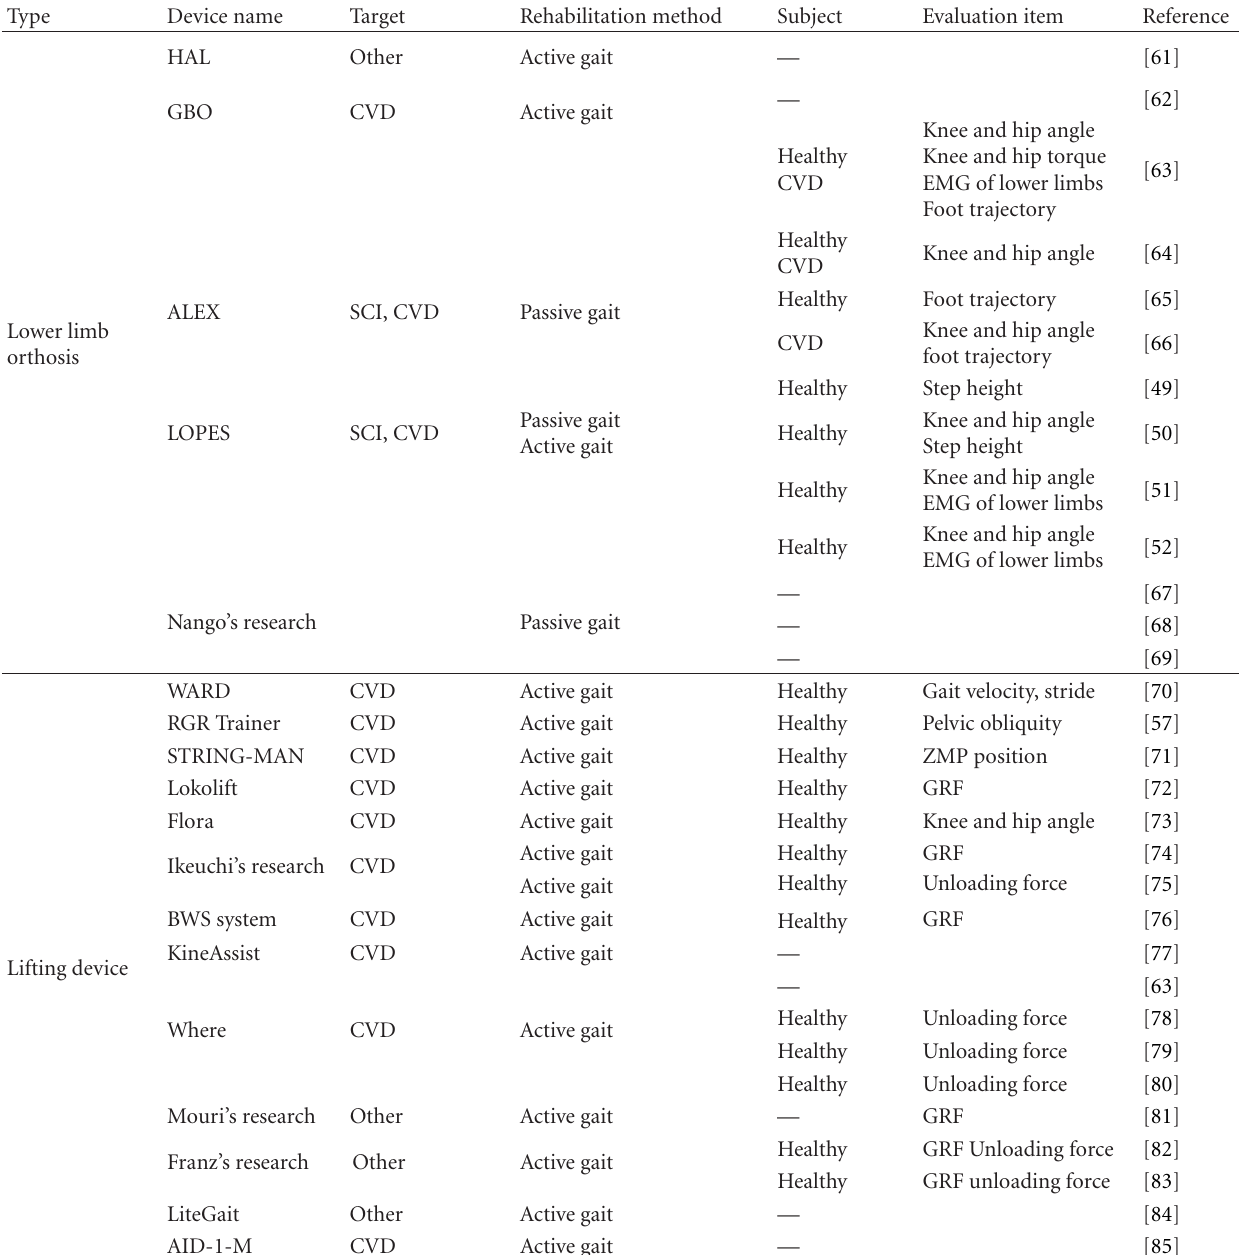
Table 1: Reference about gait rehabilitation device number